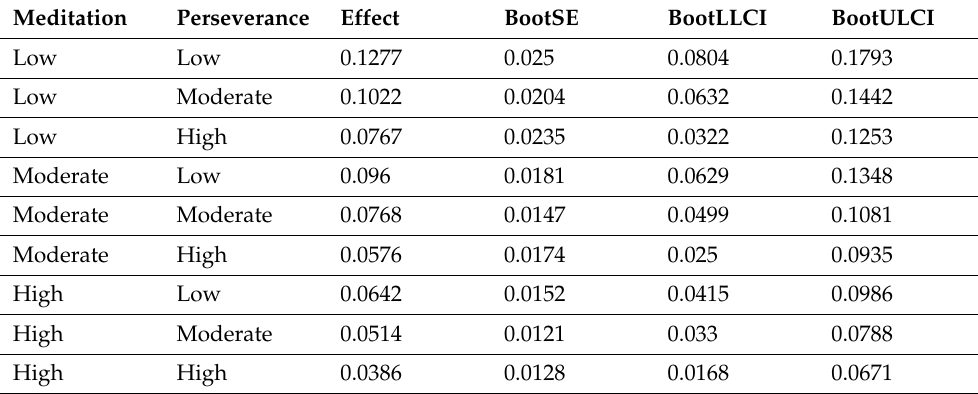
Table 5. Conditional indirect effect of family climate on depression through borderline personality disorder symptoms was moderated by meditation and